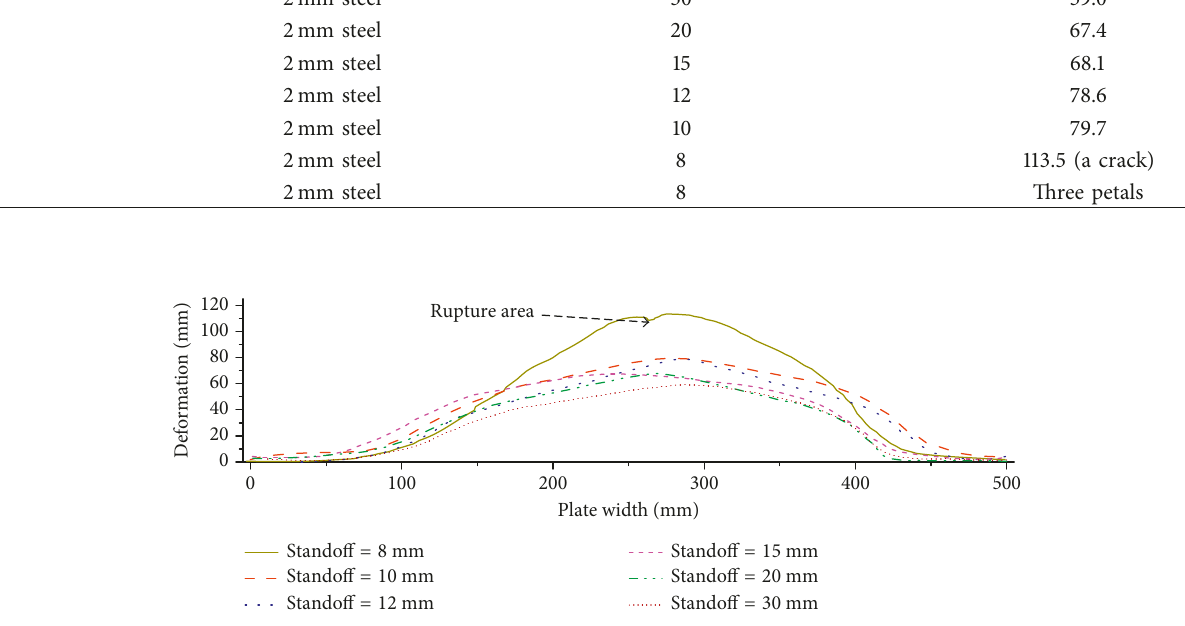
Figure 4: Deformation of bare steel plates after the test along the width